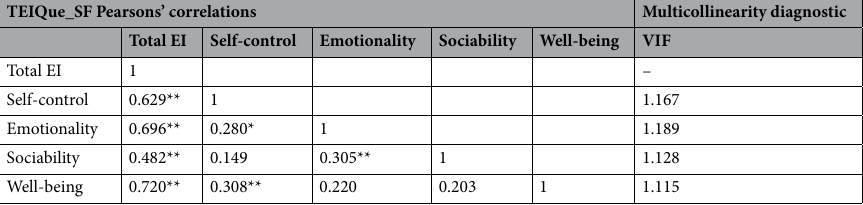
Table 1. Multi-collinearity tests (Pearson’s correlation and VIF) among the four TEIQue-SF total index and factors. ** p < 0.005.